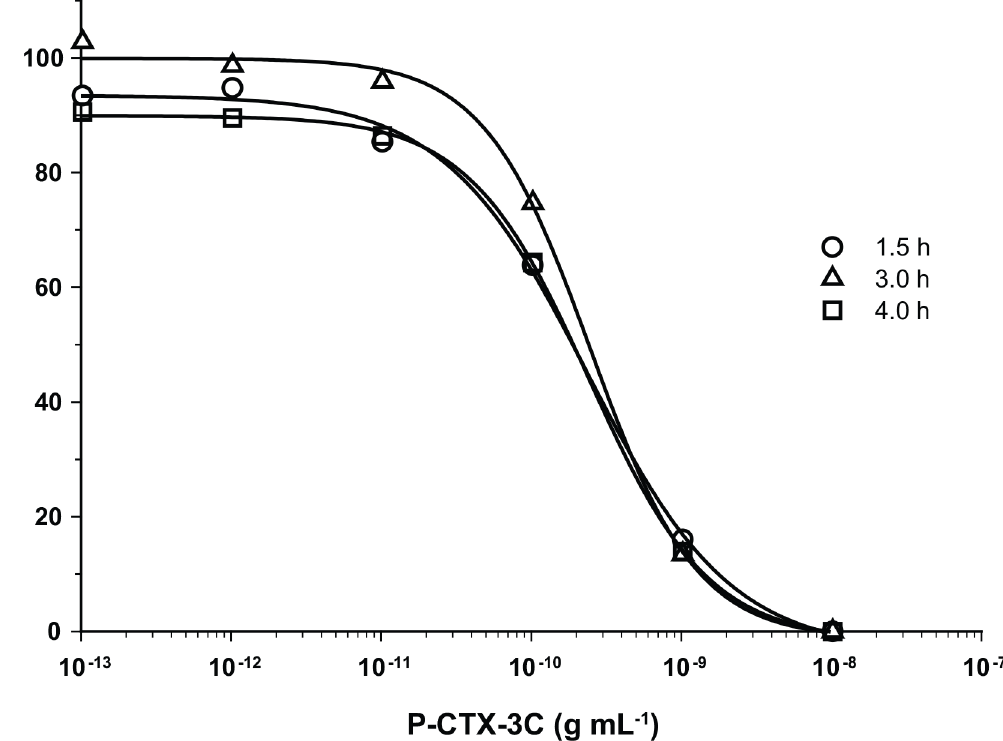
Fig 4. Time Series of RBA (F) Reaction. RBA (F) standard curves of percent (%) binding versus P-CTX-3C (g mL -1 ) where the standards were allowed to incubate with the synaptosomes for 1.5 (open circle), 3.0 (open triangle) and 4.0 h (open square).